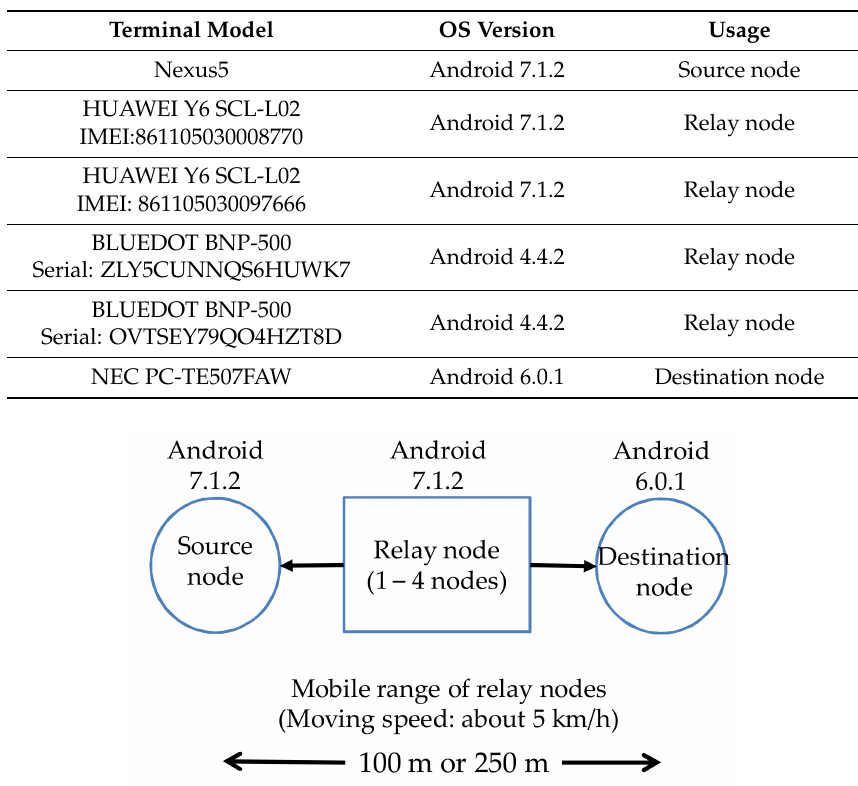
Table 8. Specifications of the terminals used in the experiment.